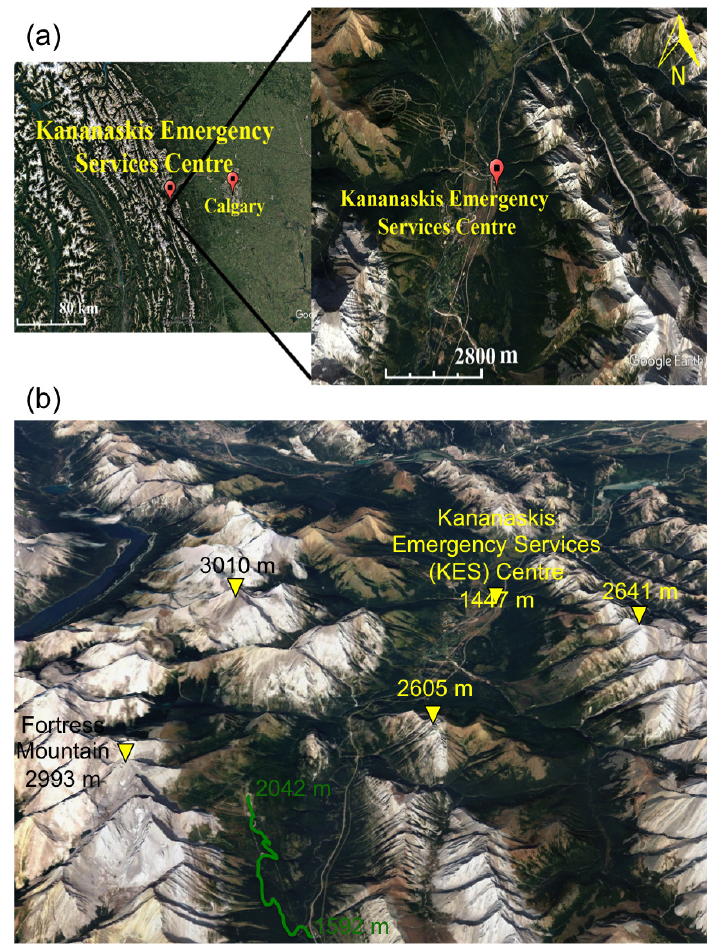
Figure 1. (a) The Kananaskis Emergency Services (KES) Centre site located in the lee of the Canadian Rockies at 50.9 ◦ latitude, − 115 . 1 ◦ longitude and (b) is surrounded by topography up to 3010ma.s.l. (Google Earth, retrieved on 16 January 2017). (c) is the local topography where the field experiment was held. Fortress Mountain is located southwest of Kananaskis and the route taken to measure temperature and precipitation using the car-sonde technique (Appendix C) is indicated in green. The elevations at the base and top of the accessible road are indicated (retrieved on 30 May